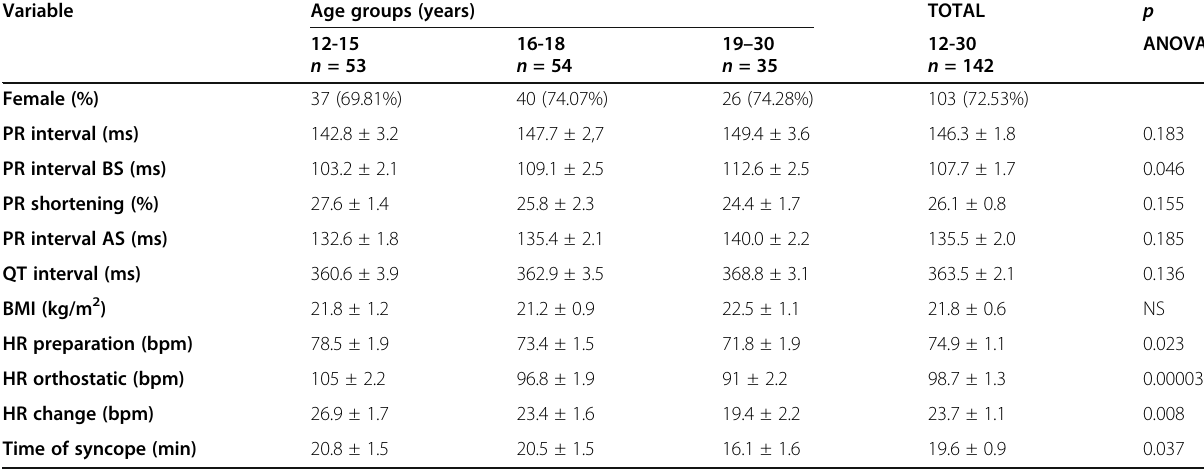
Table 3 Variables according to age groups (BS = before syncope, BP = blood pressure, AS = after syncope)